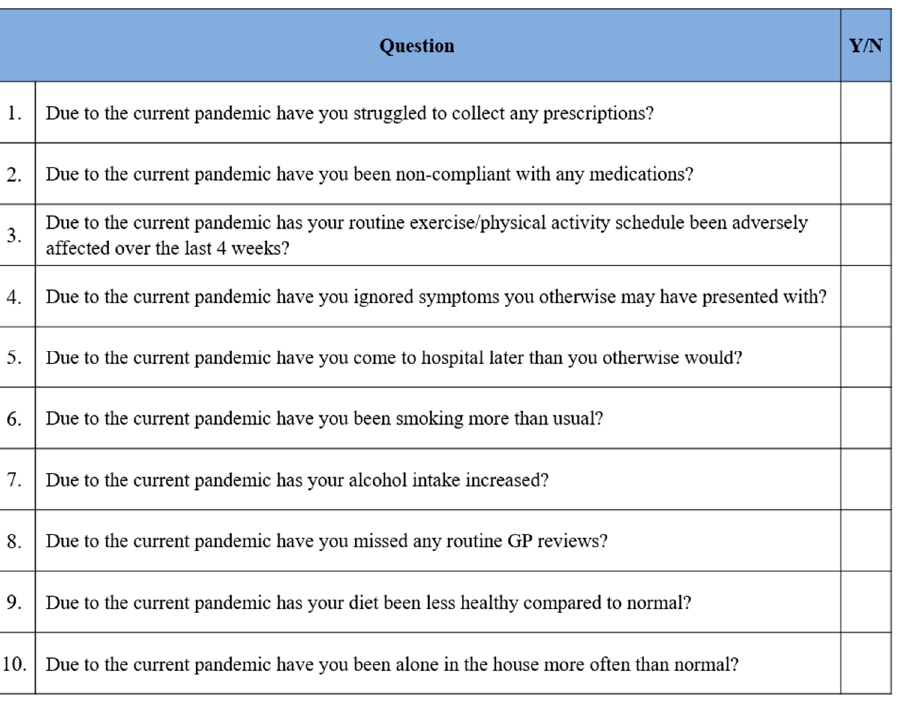
Figure 1. 2019 novel Coronavirus Patient Questionnaire. The questions were designed to identify the impact of lockdown on modifiable risk factors (concordance, lifestyle) and timely presentation to a healthcare professional due to perceived barriers, with answers recorded in a Y/N (Yes/No) binary format.